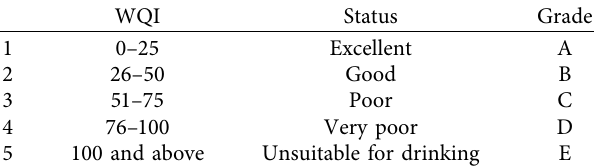
Table 2: Status of water quality based on WQI